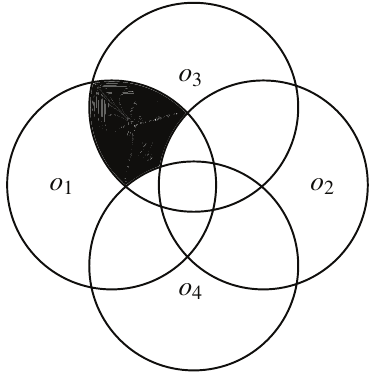
Fig. 11. Euclidean Safe